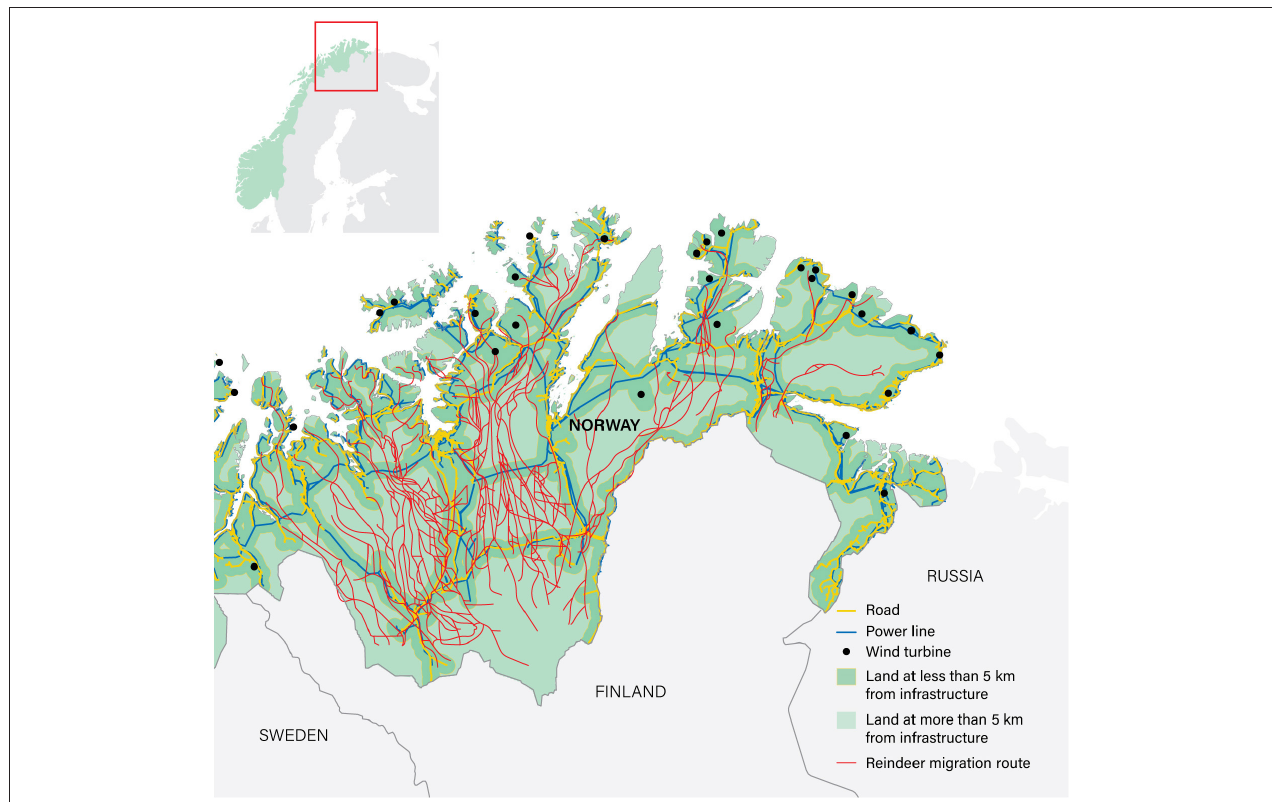
FIGURE 22 | Encroachment: map of reindeer migration routes and infrastructure in East and West Finnmark reindeer pasture areas ( Figure 3 ). There are 150 sites in this area where reindeer traversing their traditional migration routes between summer pastures at the coast and winter pastures inland (red lines) are obliged to cross roads or pass beneath high voltage power lines. Sources: Infrastructure from the Norwegian Mapping Authority; migration routes from Vorren (1962).